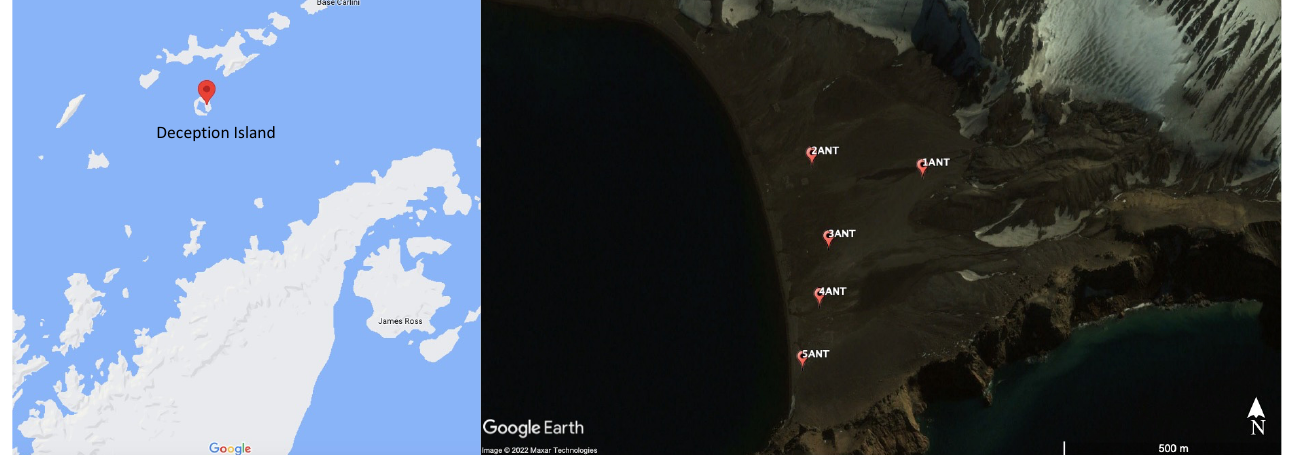
Figure 1. Map of Deception Island showing the location of sample sites. The map was taken using Google Maps (https://www.google.cl/maps; accessed on 1 April 2022) and sites are shown with red markers. Table 1. Coordinates and environmental parameters determination for soil samples.